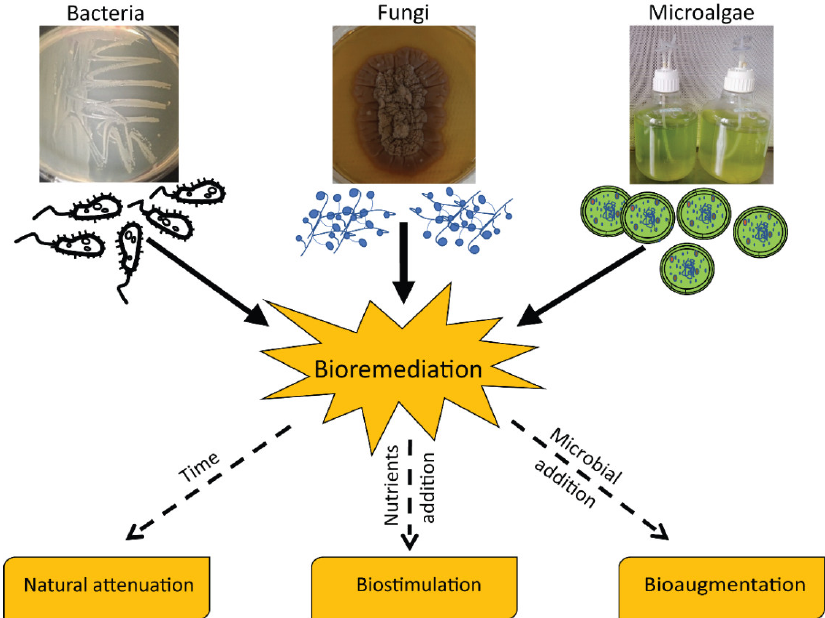
Figure 1. General scheme of bioremediation strategies involving different microbial taxa. Common microbial-based bioremediation strategies include the addition of specific compounds to stimulate autochthonous microbial assemblages (biostimulation) and/or the addition of specific microbial taxa, which display useful biodegradation/detoxification capacity (bioaugmentation